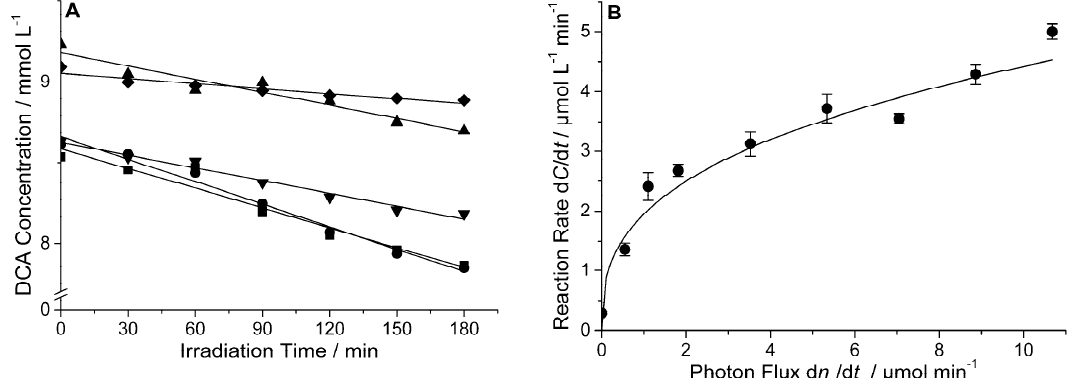
Figure 4. Photocatalytic degradation of dichloroacetic acid (DCA) at varying photon fluxes: ( A ) Concentration vs. time profiles obtained with photon fluxes of 0.54 ( ♦ ), 1.80 ( ▼ ), 3.54 ( ▲ ), 5.34 ( ● ), and 8.88 µmol min − ¹ ( ■ ); ( B ) Reaction rates d C /d t (calculated from the slopes of the plots in ( A )) vs. the photon flux. The line in (B) were calculated assuming an exponential dependence of the reaction rate on the photon flux (d C /d t ≈ [d n p /d t ] α with α = 0.35). Experimental conditions: Hombikat UV 100, γ = 5 g L − ¹, C s = 10 mmol L − ¹, V = 400 mL, pH 3, 10 mmol L − ¹ KNO 3 , air saturated, ambient temperature.